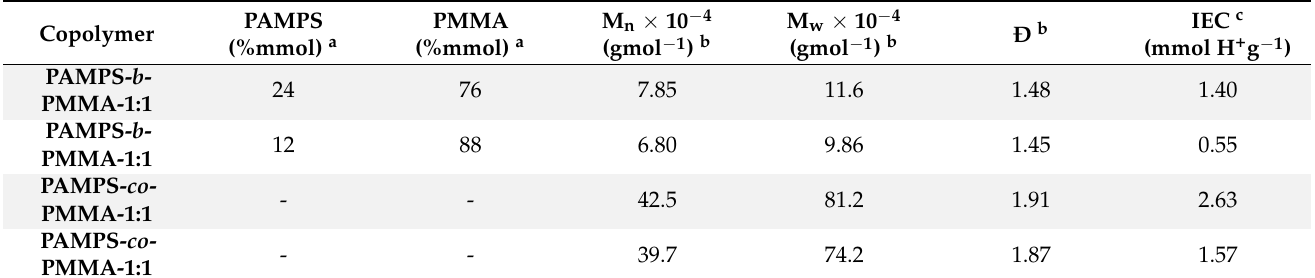
Table 1. Composition and molecular weights of block and random